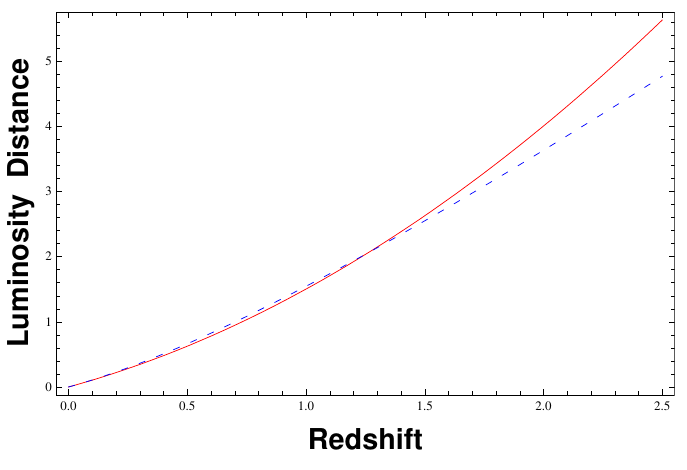
Figure 1. Luminosity distance in the new model (continuous curve) is compared with that in the Λ CDM concordance model Ω Ω Λ = 0.3 (broken curve). Distances shown on the vertical axis m = 1 − are measured in units of cH − 1 . The two models significantly depart for z ∼ > 0